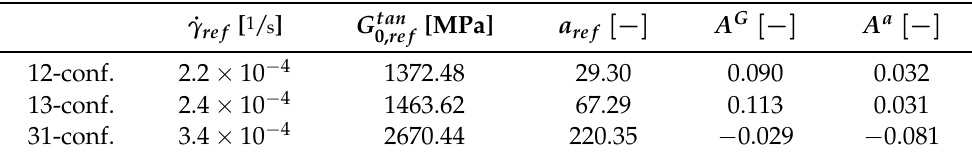
Table 4. Final material model parameters including strain rate dependency—DD